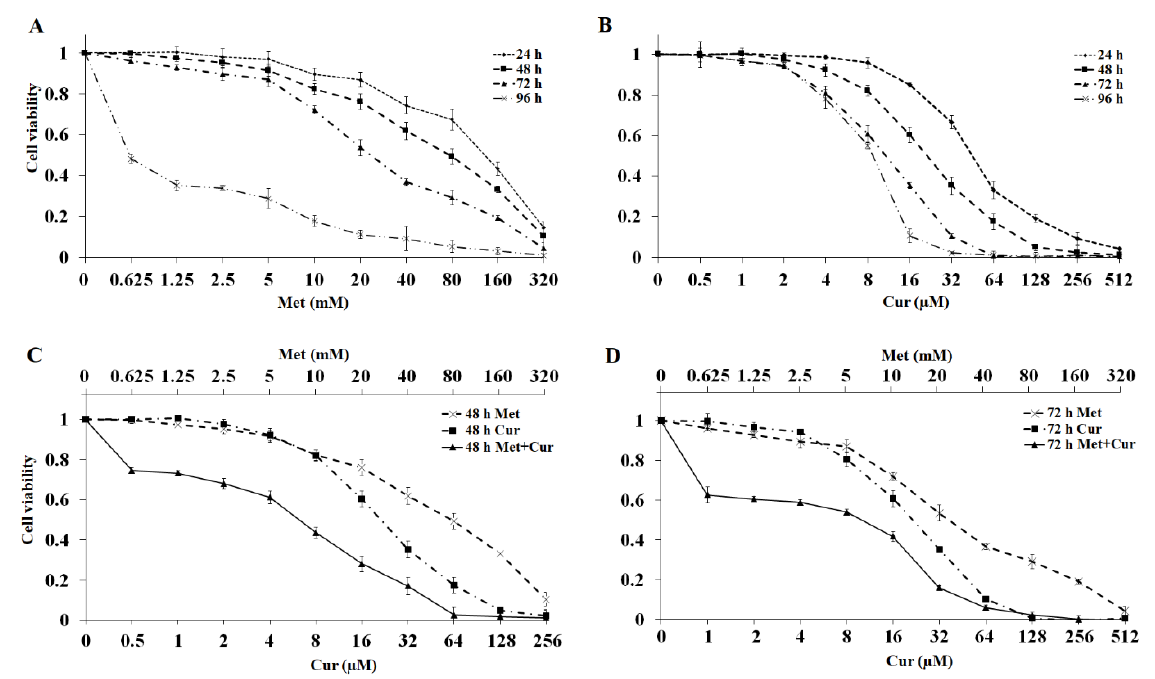
Figure 1: Combination of metformin (Met) and curcumin (Cur) synergistically inhibits viability of AGS cell line. A and B : AGS cell viability (mean ± SD) after treatment with metformin and curcumin for 24, 48, 72, and 96 hours. C and D : AGS cell viability (mean ± SD) for combinatorial treatment with metformin and curcumin (1250:1 for 48 hours and 625:1 for 72 hours). Doses of metformin in the top row and curcumin in the bottom row of the graph are presented, and both should be considered for combination charts. Each experiment was performed independently in triplicate for each data